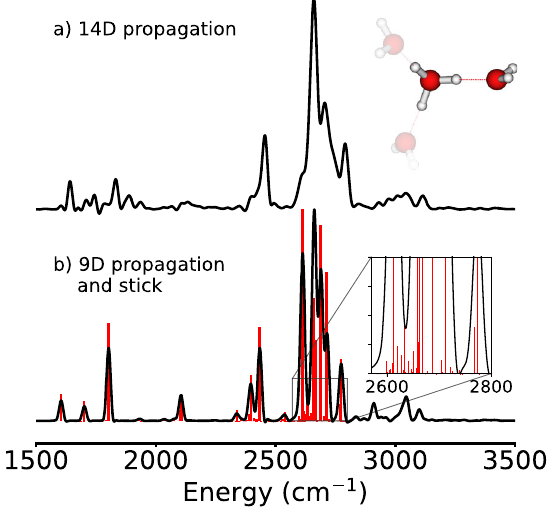
Fig. 4 | Spectra for reduced H 5 O + 2 models. Spectra obtained with the z-componentofthedipolemomentsurfacesforreducedH 5 O + 2 modelsbyfreezing modestopositionscorrespondingtotheirexpectationvaluesforH 9 O + 4 a obtained withadipole – dipole-correlationfunctionof2000fsusinga14Dmodel, b obtained with a dipole – dipole-correlation function of 2000 fs using a 9D model (black curve), and obtained as a stick spectrum using eigenstates (red lines). Source data are provided under